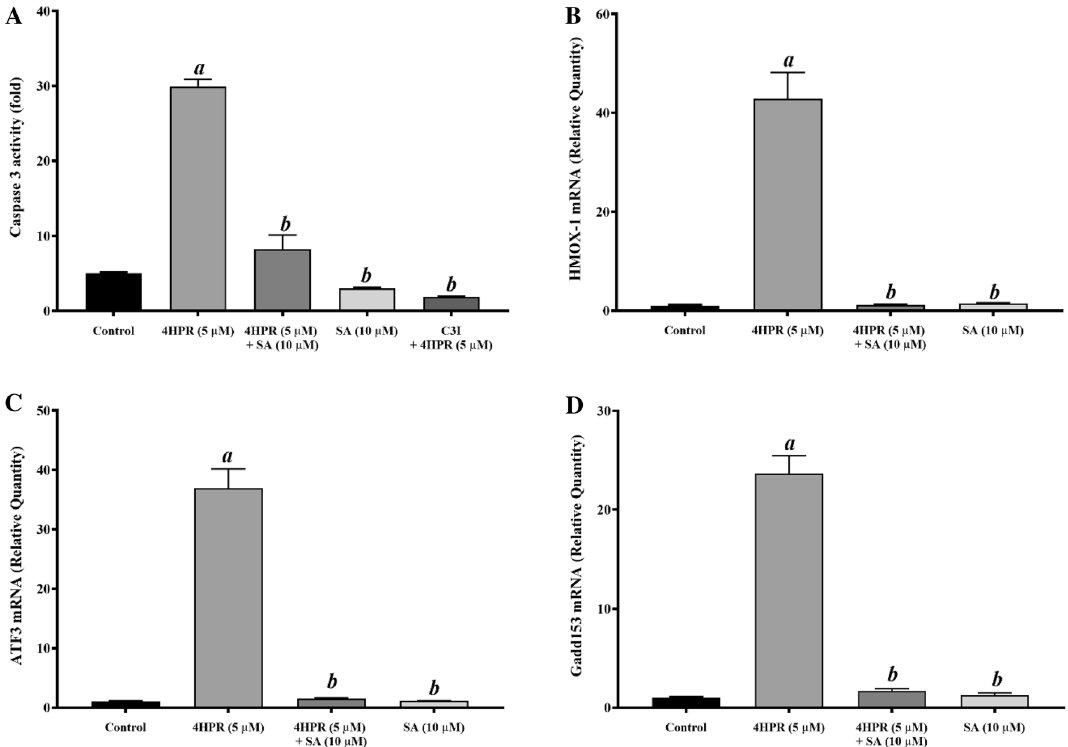
Figure 2. Inhibition of fenretinide-induced Caspase 3 activity and expression of genes involved in oxidative stress in ARPE-19 cells by sterculic acid pretreatment. ( A ) Fenretinide-induced caspase 3 activity is prevented by pretreatment with sterculic acid (SA). The cultured cells were treated with 5 M fenretinide in the presence or absence of 1 h pretreatment with SA, or with C3I, a caspase 3-specific inhibitor. Caspase 3 activity was estimated as described under “Experimental Procedures”; ( B ) Fenretinide-induced HO-1 (HMOX) mRNA expression is prevented by pretreatment with SA. ( C ) Fenretinide-induced ATF3 mRNA expression is prevented by pretreatment with SCD inhibitor SA. ( D ) Fenretinide-induced GADD153 mRNA expression is prevented by pretreatment with SA. The ARPE-19 cells were treated with fenretinide in the presence or absence of SA, and the total RNA preparations were analyzed by qPCR as described under “Experimental Procedures”. The values are mean ± SD of three independent experiments performed in quadruplicate. To test for significant differences between treatment groups, one-way analysis of variance (ANOVA) was used. In the graphs, ‘ a ’ indicates statistical significance difference between fenretinide treated and untreated controls, and ‘ b ’ indicates statistical significance between fenretinide treated and fenretinide treated with inhibitors, and inhibitors alone ( a b p <